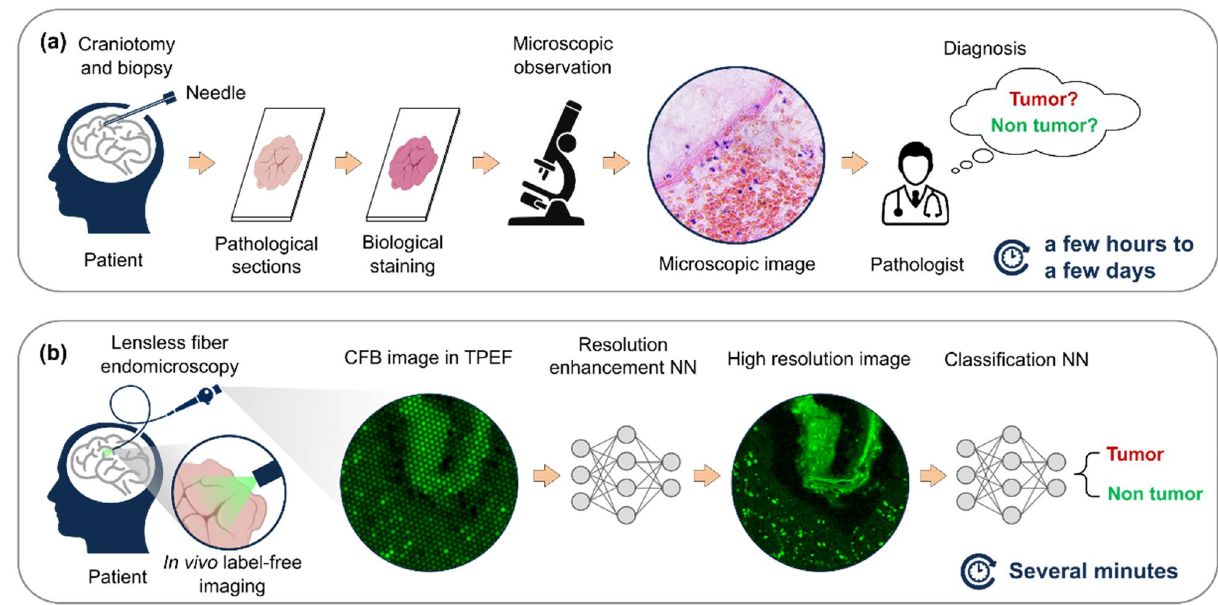
Figure 1. Workflow of biopsy diagnosis and end-to-end diagnosis. ( a ) A biopsy is the main way doctors diagnose most types of cancer diagnosis. It requires specialized surgical skills, histology laboratory and trained personnel. The whole procedure is cumbersome and time-consuming. ( b ) The learning-based end-to-end diagnosis directly obtains the tissue image via minimally invasive fiber-optic endoscope. Deep neural network (DNN) improves resolution for reliable prediction of whether the tissue is a tumor. It is promising for real-time and in situ tumor